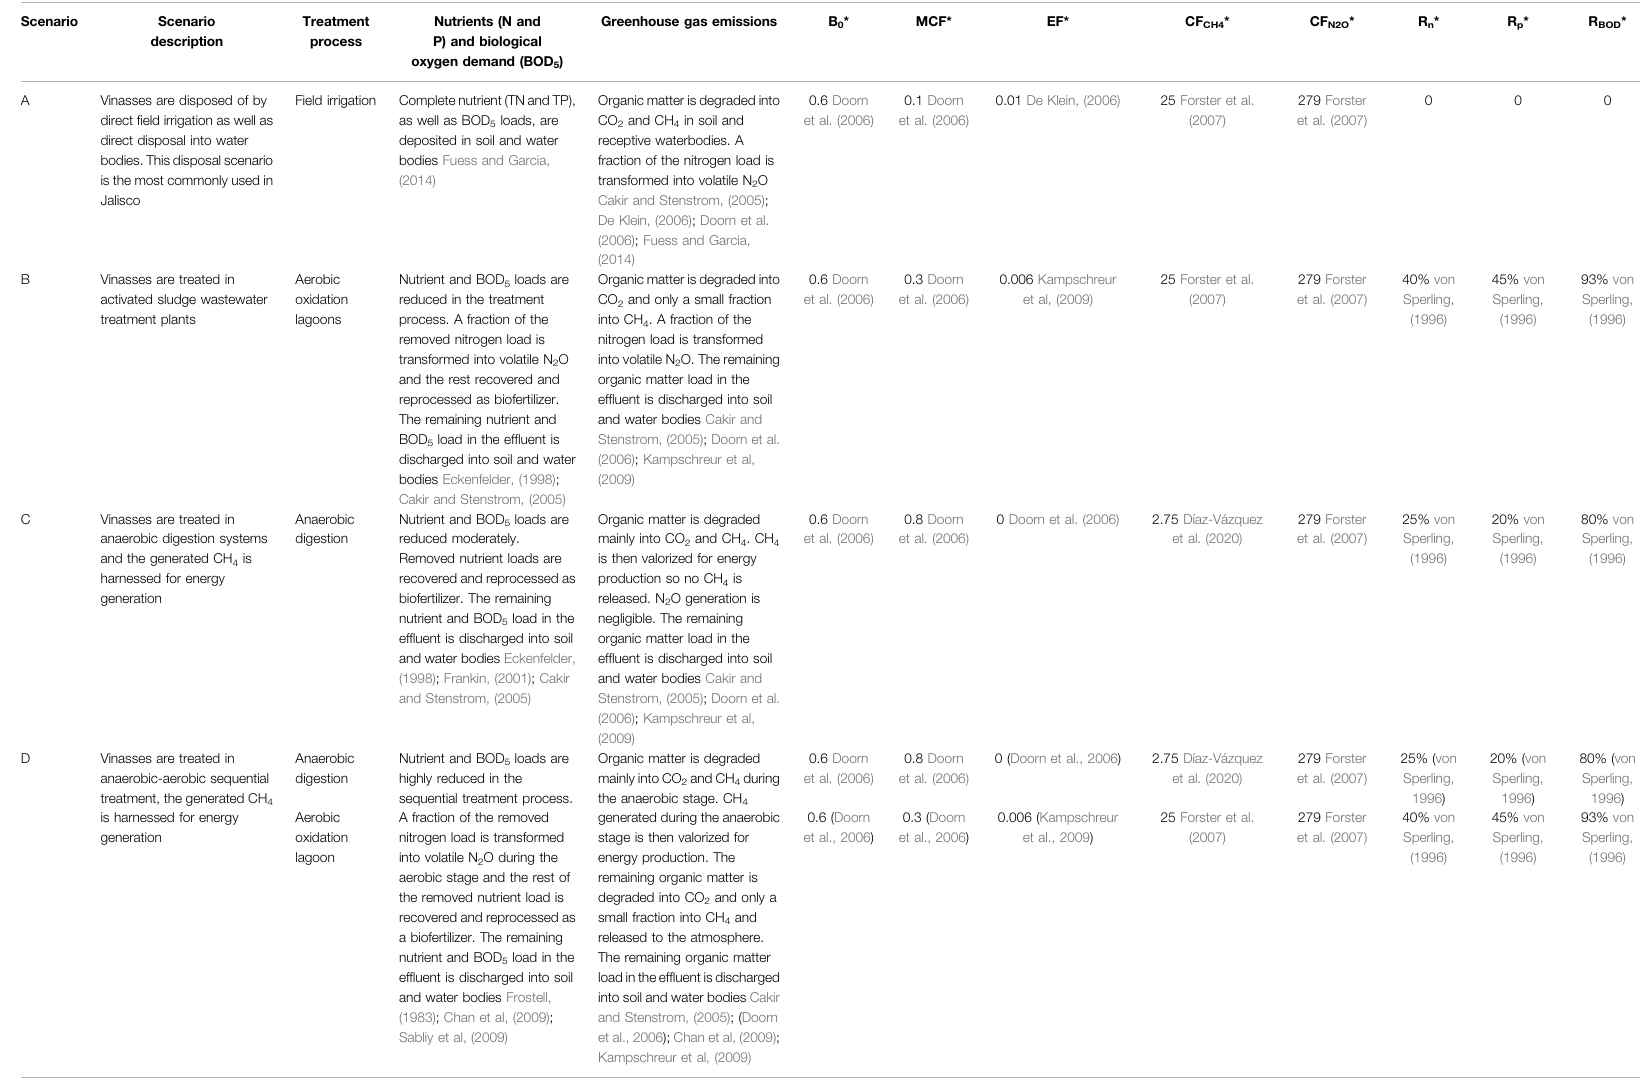
TABLE 4 | Scenario description and parameters used for the calculation of the nitrogen and phosphorus released to the environment and the CO 2 eq emissions for each proposed scenario.